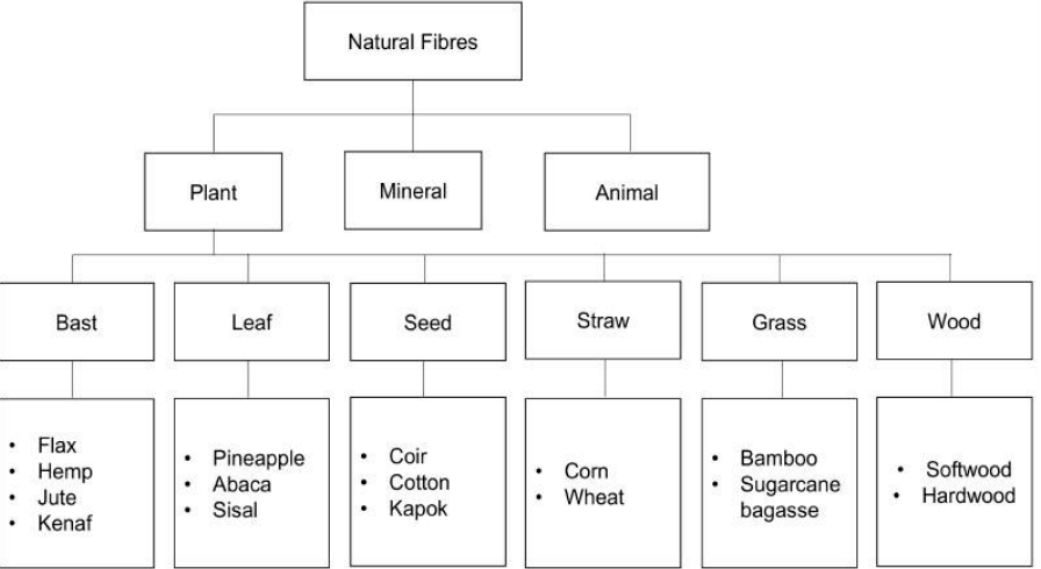
Figure 4. Schematic representations of natural fibres. Adapted with permission from Ref. [95]. Copyright 2021 MDPI.